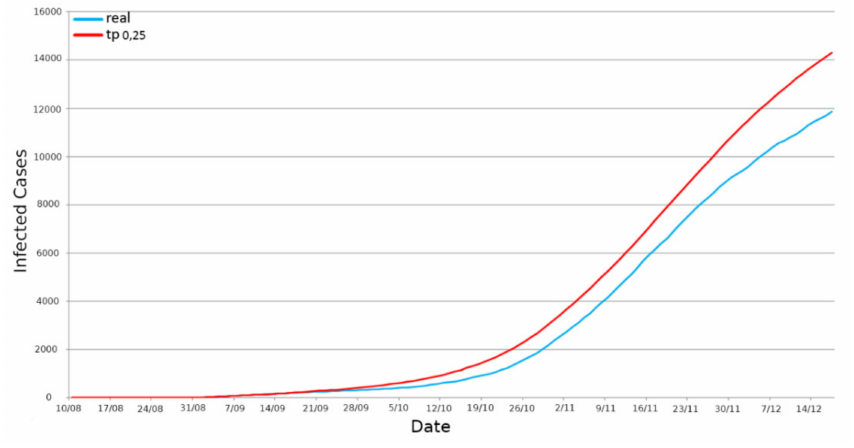
Figure 11. Positives’ incremental representation—Reggio Emilia province, Emilia Romagna